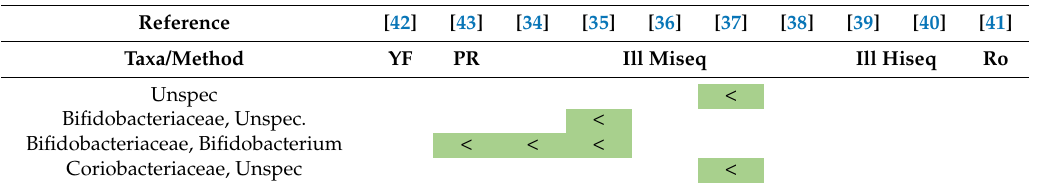
Table 4. Actinobacteria.